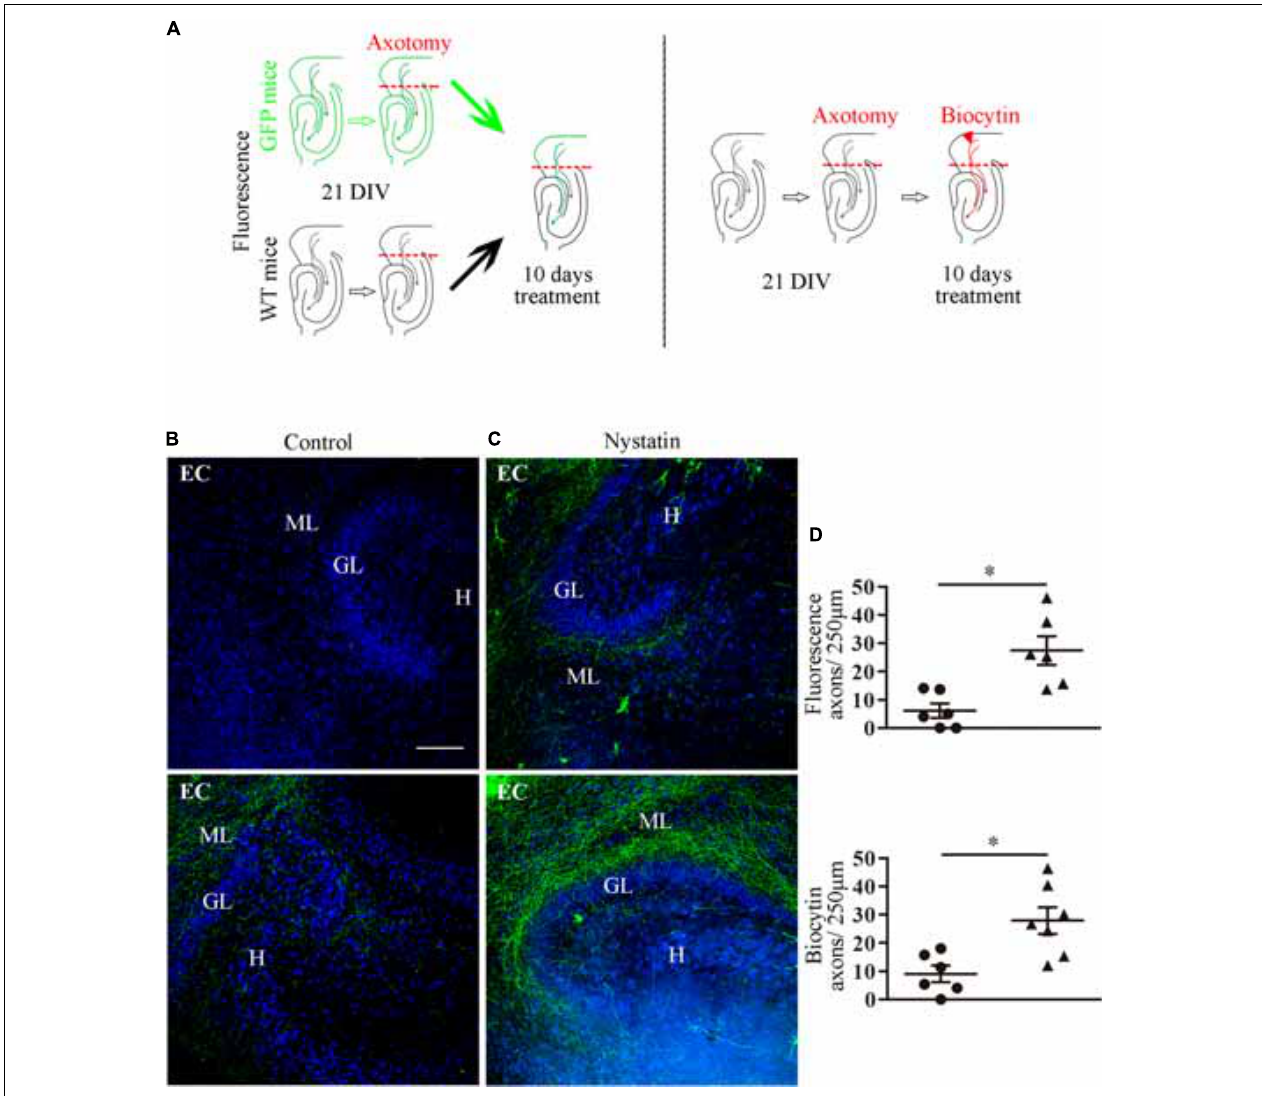
FIGURE 6 | Nystatin increases EC axon regeneration in organotypic cultures. (A) Schematic diagram that summarizes the experimental protocol. Slice co-cultures from P0 actin-GFP and WT mice were isolated, as described in Section “Materials and Methods” and kept in culture 21 DIV. Axotomy of the EHP was performed, and slices were treated for 10 DIV with control medium or 5 µ g/ml Nystatin. (B) Representative examples of control hippocampal slices show virtually no regenerative axons (upper panel) or very few regenerative axons (lower panel). (C) Examples of hippocampal slices treated with Nystatin show moderate axonal regeneration (upper panel) or robust axonal regeneration (lower panel). Axons that cross a 250 µ m line were counted in three random fields near the dentate gyrus in each slice. Data represent means ± SEM (D) . One dot corresponds to one slice ( t -Test ∗ p < 0.05). Scale bar 100 µ m. ML, molecular layer; GL, granule cell layer; H,